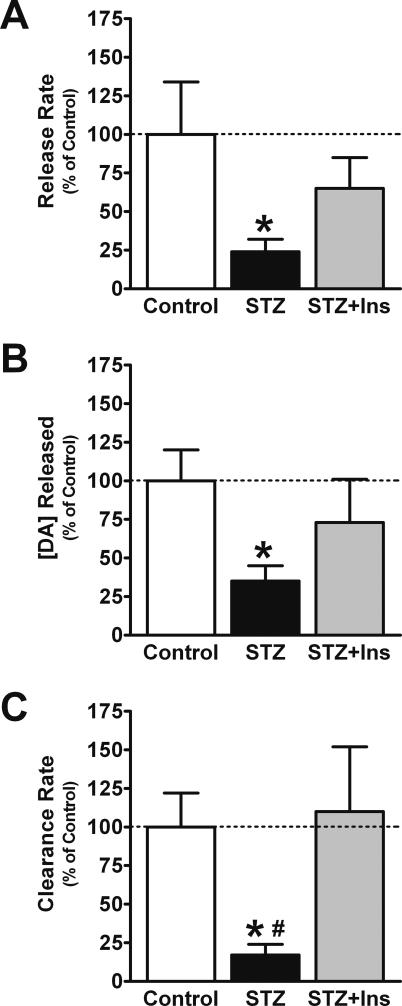
Local Infusion of Insulin Restores AMPH-Evoked DA Release in Striatum of STZ-Treated RatsSummary data for HSCA (n = 5–7). When measured in the dorsal striatum and compared to saline-treated control subjects, STZ-induced depletion of insulin (STZ) resulted in a significant reduction in the rate of DA efflux in response to local injection of AMPH (400 μM/125 nl; (A) as well as a decrease in the maximum amount of released DA (B) and the rate of DA clearance (C) with respect to control. These findings provide a replication of those shown in Figure 2 in a separate cohort of rats. In contrast, when exogenous insulin (10 μM/100 nl) is locally applied in STZ animals 2 min prior to AMPH (STZ+Ins), all three of these electrochemical parameters are normalized to levels approximating control. One-way ANOVA (F
2,14 = 2.46; p < 0.05); Mann-Whitney (p < 0.05 compared to Control* and STZ+Ins#).